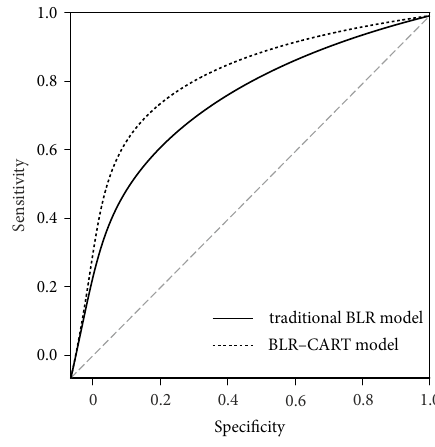
Figure 3. ROC curves of BLR–CART model and traditional BLR model